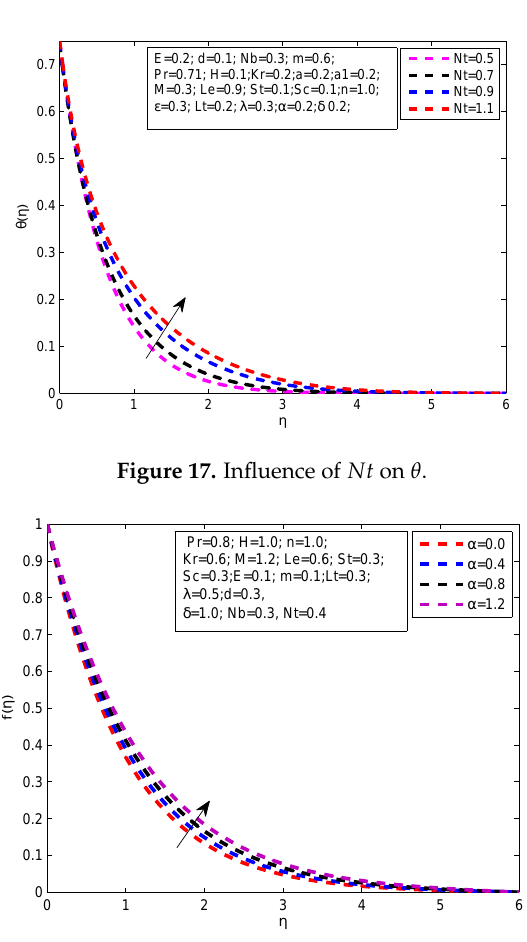
Figure 18. Variation of f (cid:48) for distinct values of α .